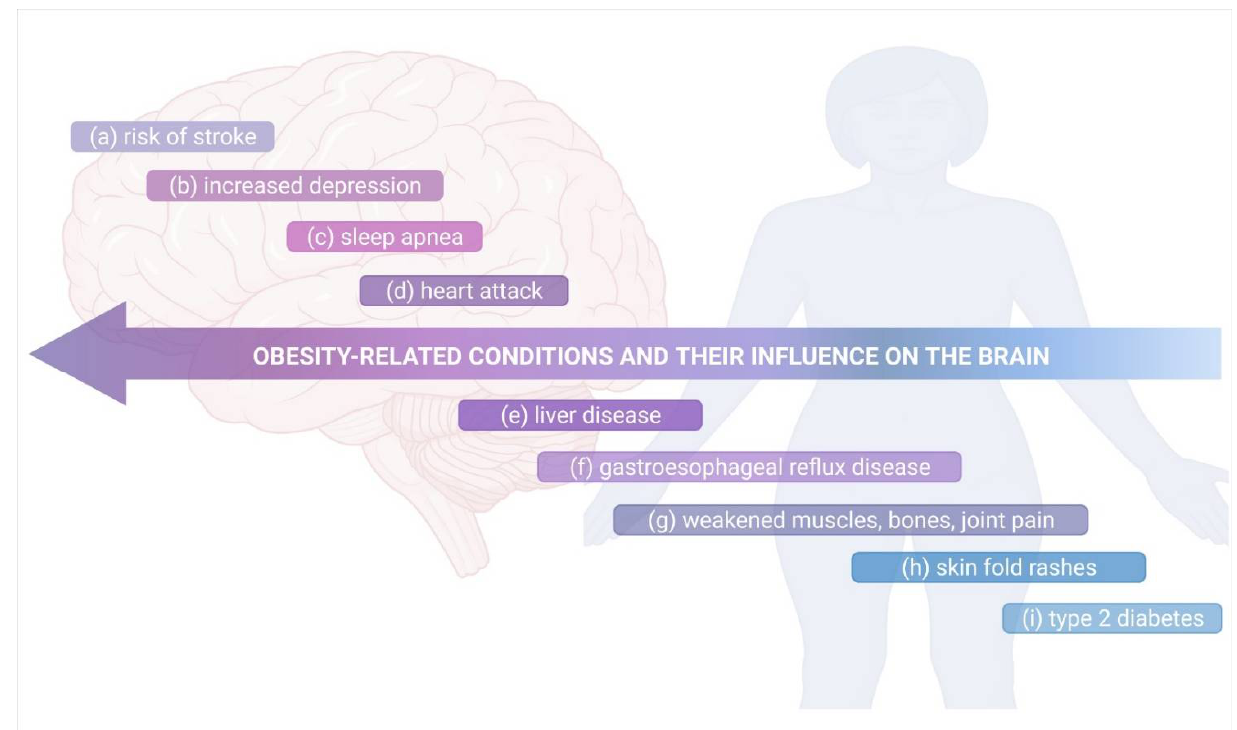
Figure 5. The obesity-related conditions and their influence on the brain. Obesity can: ( a ) lead to high blood pressure, causing stroke; ( b ) influence the mental health, increasing depression and issues of body image; ( c ) cause airways to small, leading to sleep apnea, where the breathing stops for periods of the time at night; ( d ) harden the arteries, increasing thereupon the risk of heart attack due to high blood pressure, cholesterol and blood sugar occurring in this disorder; ( e ) built up excess fat around the liver, leading to damage and its failure; ( f ) induce a higher risk of GERD, where stomach acid